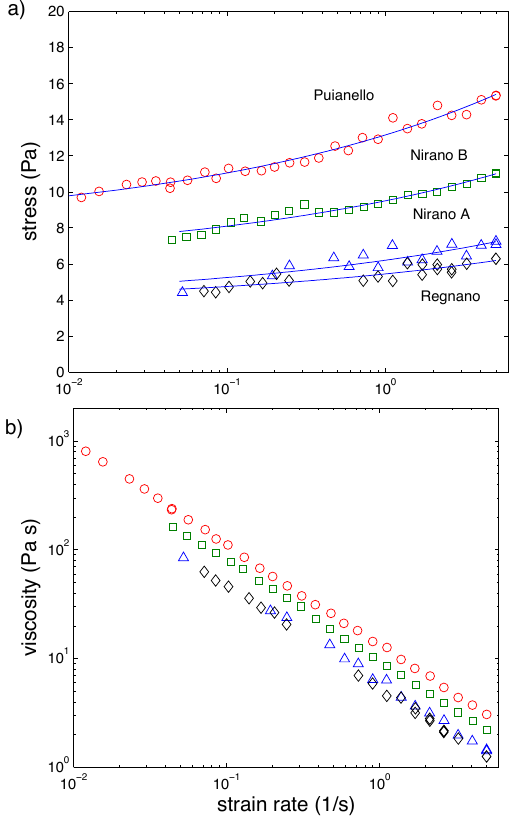
Fig. 7. Rheological measurements showing (a) shear stress as a function of strain rate and (b) apparent viscosity (shear stress/strain rate) as a function of strain rate. The curves in (a) are best fits of the Herschel-Bulkley model with n = 0 . 22 (parameters listed in Ta- ble 1). Symbols and colors in (a) and (b) are the same.